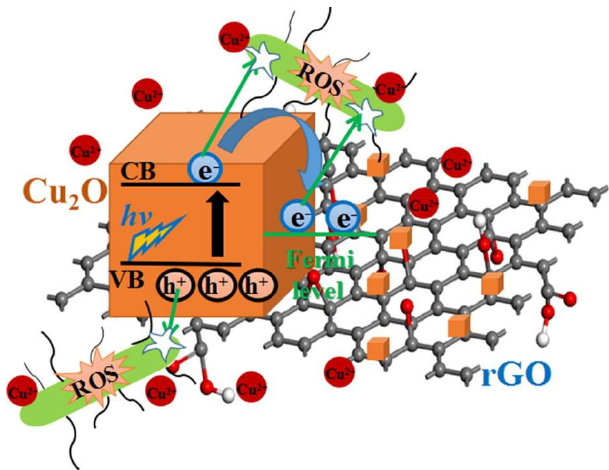
Figure 11. Reactive oxygen species (ROS) production caused by the heterostructured nanocomposites rGO-Cu 2 O under light illumination. Reproduced with permission from ref. [94]. Copyright © 2019, Elsevier.